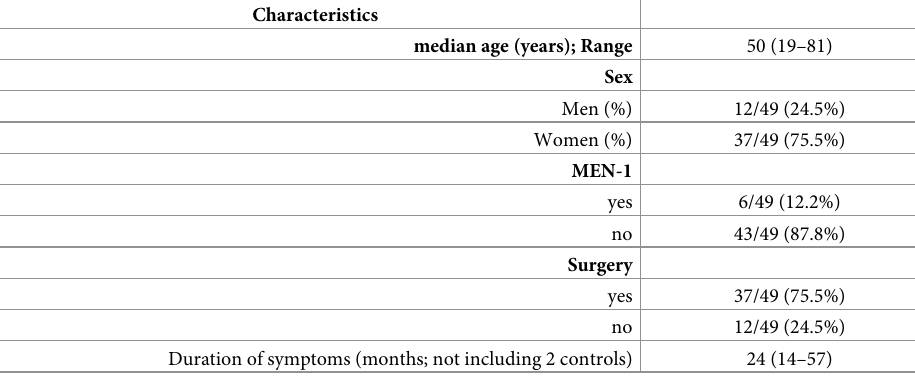
Table 1. Demographics and characteristics in EHH